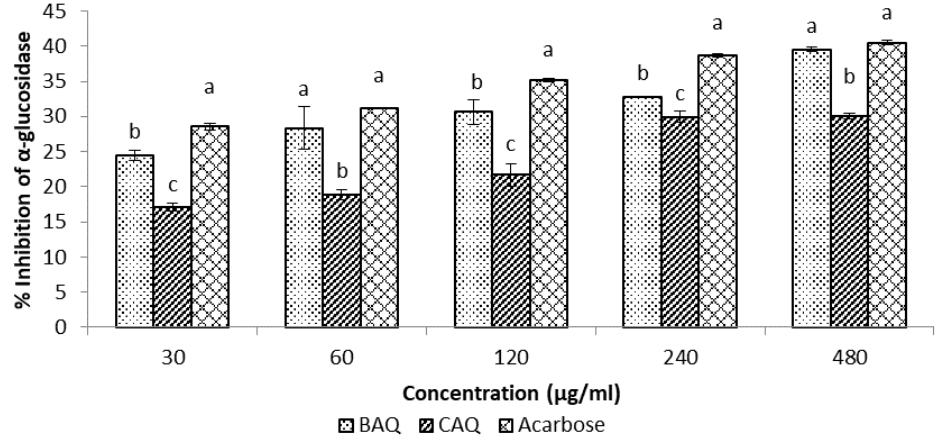
Figure 3. Inhibitory effects of the cold aqueous (CAQ) and boiled aqueous (BAQ) extracts of H. petiolare on α-glucosidase enzyme’s activity. Data expressed as mean ± SD (n = 3). Columns with the same alphabet within the same concentration are not significantly different.